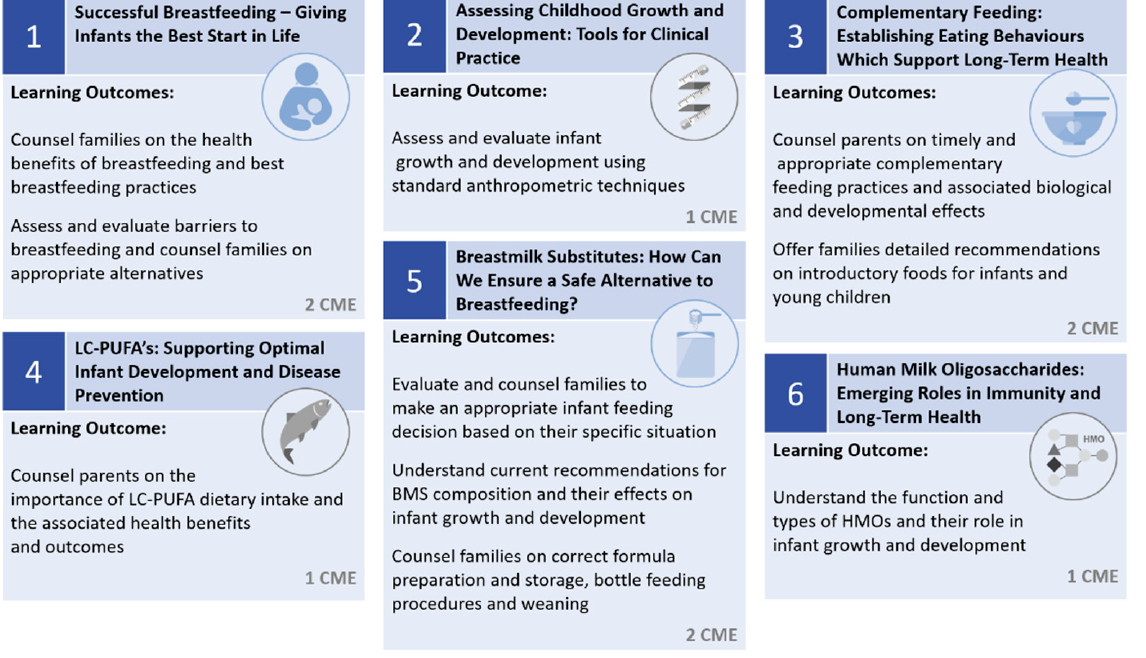
Figure 1. The Early Nutrition Specialist (ENS) Curriculum. Note: LC-PUFA stands for Long Chain Polyunsaturated Fatty Acid.